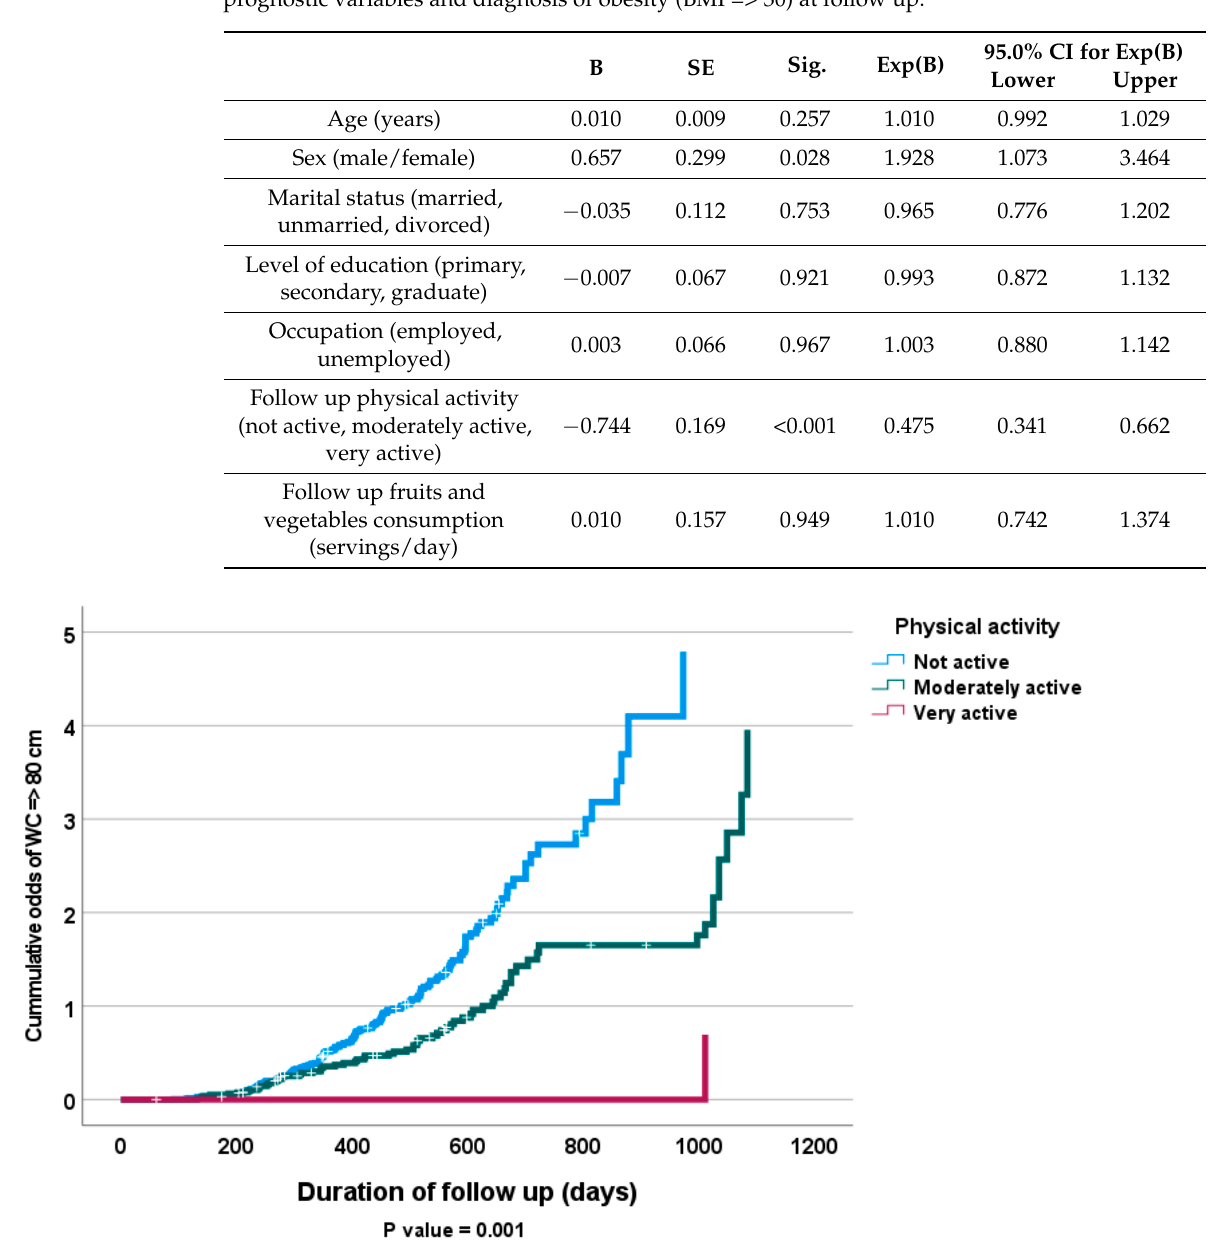
Figure 2. Kaplan–Meier of cumulative odds of diagnosis of obesity (BMI => 30) at follow up in all subjects according to levels of physical activity.